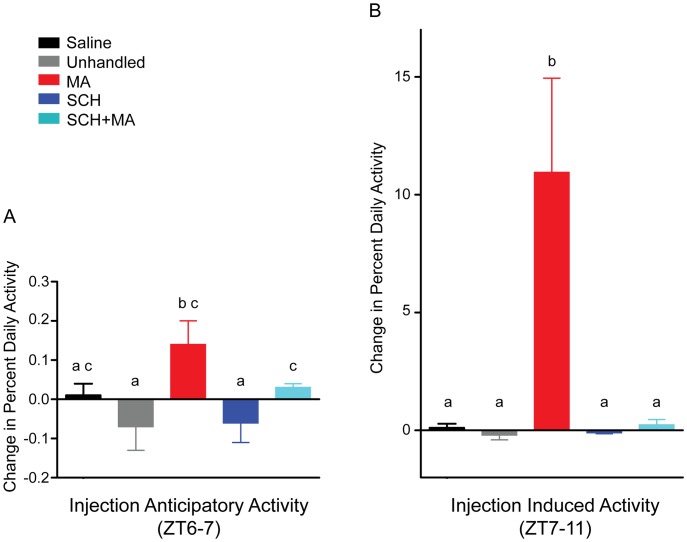
Scheduled daily MA injections result in anticipatory and induced activity.A) Injection anticipatory activity. For each mouse, activity level from ZT6-7 (1h prior to injection) was scored (as percent of average daily activity) on the last 7 days of injection and compared to that animal’s activity level from ZT6-7 on 4 days prior to the start of the injection paradigm (ZT6-7 corresponds to the area to the left of the pink vertical bar in Fig. 2B, D). The difference in activity levels are presented as mean ± SEM. Different letters above bars represent significant differences (p<0.05) between groups (i.e., “a c” differs from “b c” but not from bars designated as “a” or “c” alone, “b” differs from “a c” and “a,” “c” differs from bars labeled “a” alone). B) Injection induced activity. For each mouse, activity level from ZT7-11 (4h post injection) was scored (as percent of average daily activity) on the last 7 days of injection and compared to the activity level from ZT7-11 on 4 days prior to the start of the injection paradigm (ZT7-11 corresponds to the area to the right of the pink vertical bar in Fig. 2B, D). The difference in activity levels are presented as mean ± SEM. Different letters above bars represent significant differences (p<0.05).